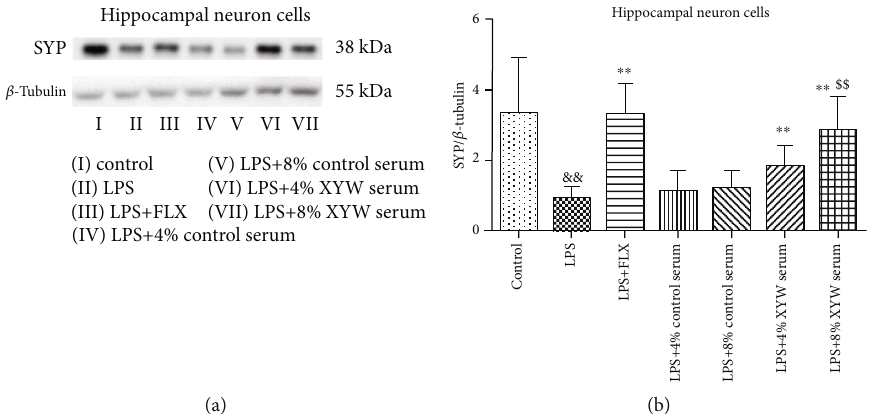
Figure 5: Xiaoyao Pill serum improved the levels of SYP in cell lysates. Representative blots and statistical graphs of relative protein expression of SYP (a, b). The results were expressed as the mean ± SD ( n = 6 ). && p < 0 : 01 compared to the control group. ∗∗ p < 0 : 01 compared to the LPS group. $$ p < 0 : 01 compared to the LPS+8% control serum group.